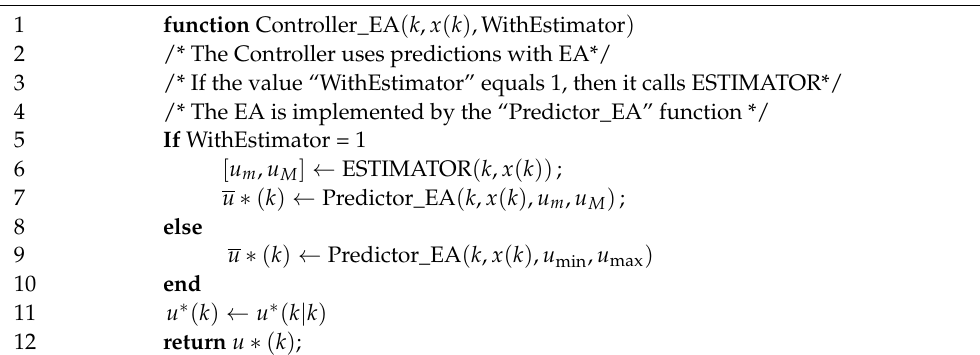
Algorithm 2 Receding Horizon Controller with EA and